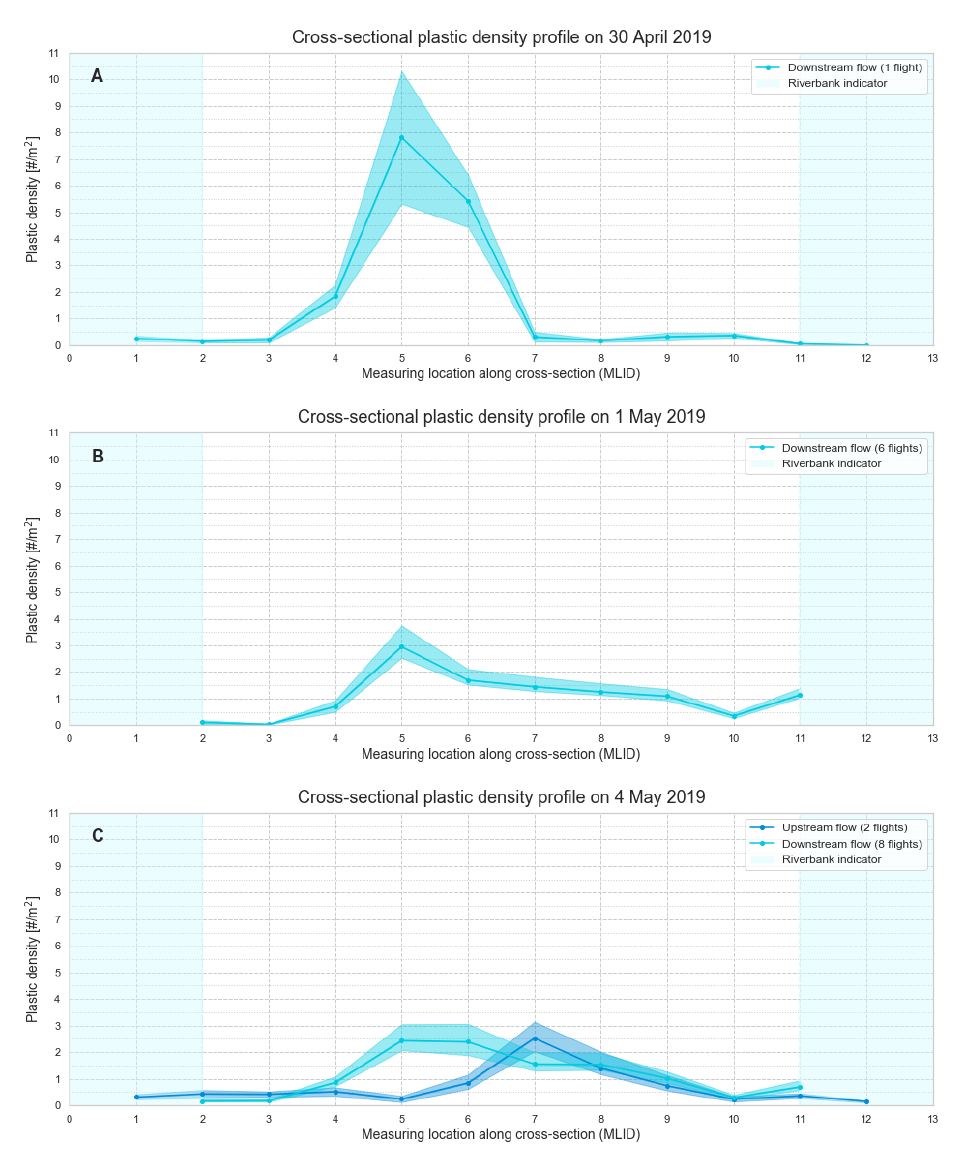
Figure 5. Cross-sectional profiles of observed plastic density and fictional plastic density for the case H actual = H recorded + ∆ H over the river width for 30 April, 1 May and 4 May 2019. The maximum of the error band indicates the maximum of the plastic density at height H recorded + ∆ H or the plastic density √ N , and the minimum of the error band indicates the at height H recorded plus measurement error σ / minimum of the plastic density at height H recorded and the plastic density at height H + ∆ H minus the measurement error of the sample. ( A ) The cross-sectional profile of the mean plastic density on 30 April; ( B ) the cross-sectional profile of the mean plastic density on 1 May 2019; and ( C ) the cross-sectional profile of the mean plastic density on 4 May